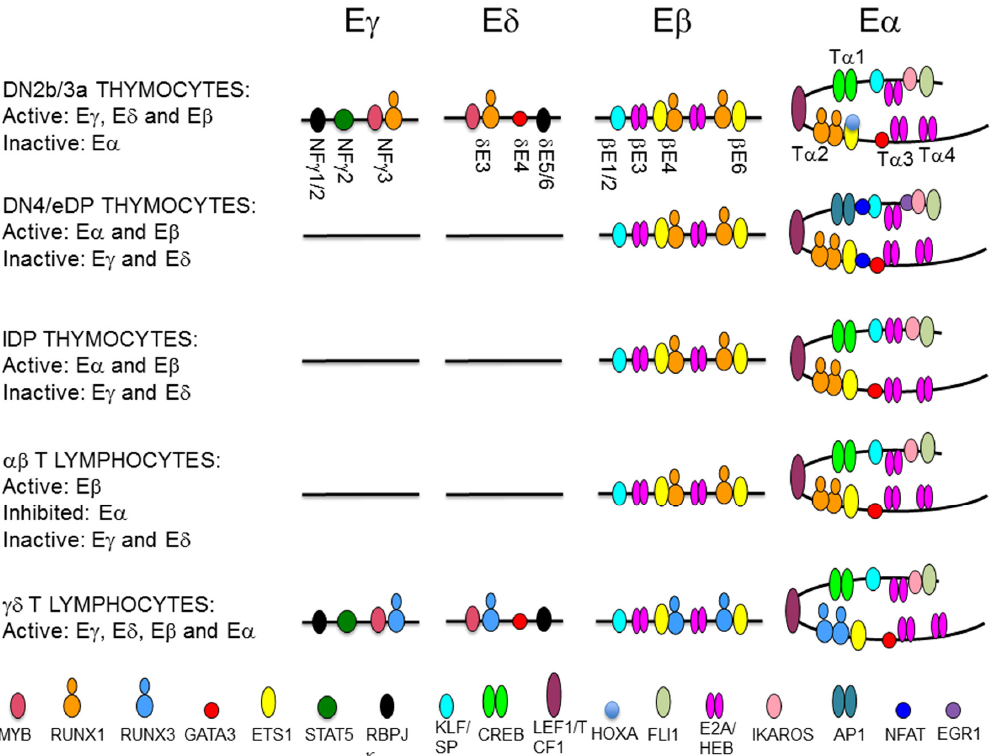
Figure 8. Representation of transcription factor (TF) binding to T-cell receptor (TCR) enhancers during thymocyte development. The diagram depicts the TF that are recruited to the TCR γ enhancer (E γ ), the TCR δ enhancer (E δ ), the TCR β enhancer (E β ), and the TCR α enhancer (E α ) during T cell maturation. The location of defined enhancer elements are indicated. TFs are represented as colored ovals as indicated.